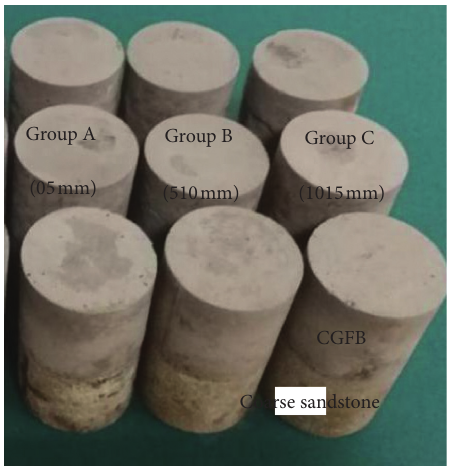
Figure 4: Coarse sandstone-CGFB composite samples with dif- ferent coal gangue particle sizes.